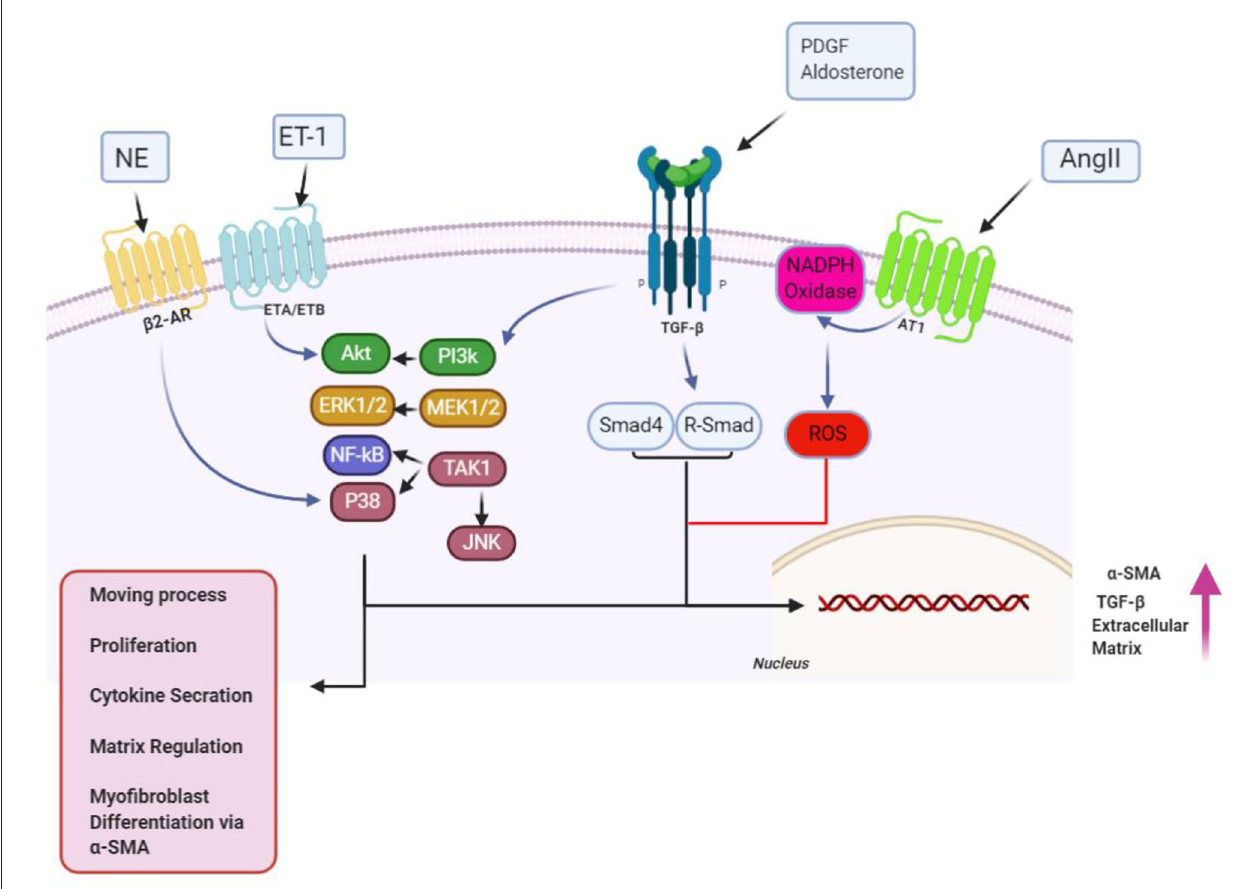
FIGURE 2 | Over the proliferation phase of infarct remedial, fibrogenic growth, as well as neurohumoral mediating factors, stimulates myofibroblast proliferating and migrating, along with activating. A broad scope of fibrogenic mediators, engaged in this phase of cardiac, has been considered in activation of myofibroblast. Neurohumoral mediating factors, including angiotensin II (AngII), aldosterone, and norepinephrine (NE), and growth factors [transforming growth factor (TGF- β ), fibroblast growth factor, and platelet-derived growth factor (PDGFs)], together with special matrix proteins, including ED-A fibronectin and matricellular proteins, have cooperation in activating intracellular signaling pathways, which enhance conversion, as well as proliferation of myofibroblast, while modulating ECM protein expression, and of genes related to matrix metabolism. Design of the cartoon took place according to Servier Medical Art (https://smart.servier.com). AR1/4, adrenergicreceptor; ET1/4, endothelin; MMP1/4, matrix metalloproteinase; NF1/4, nuclear factor; ROS1/4, reactive oxygen species 1/4; SMA1/4, smooth muscle actin; TIMP1/4, tissue inhibitor of metalloproteinase. This figure was adapted from Humeres and Frangogiannis (119).